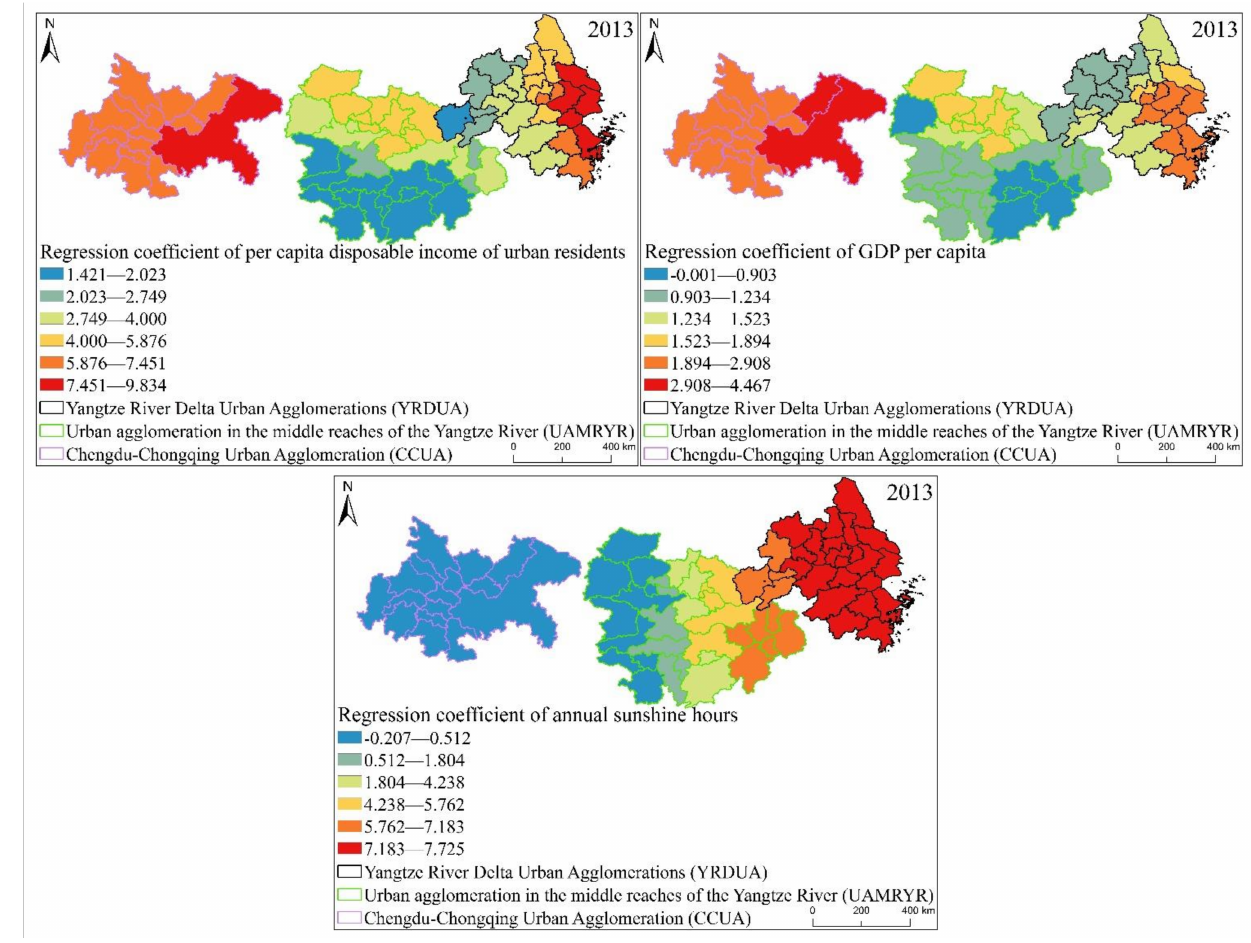
Figure 21. The spatial distribution map of the regression coefficients of the GWR model in fluencing factors of EPC in the three major urban agglomerations of the YREB in